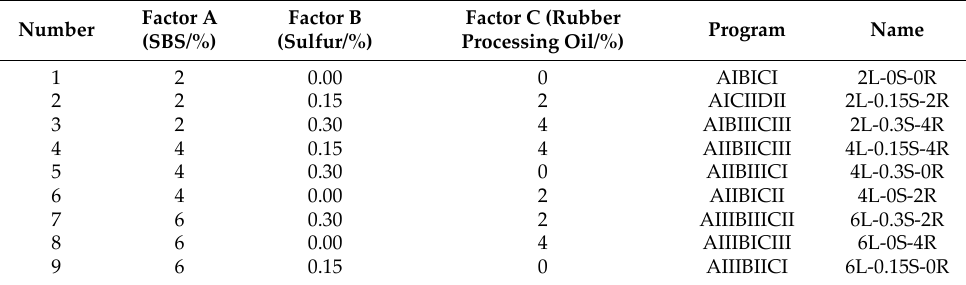
Table 4. Orthogonal experimental